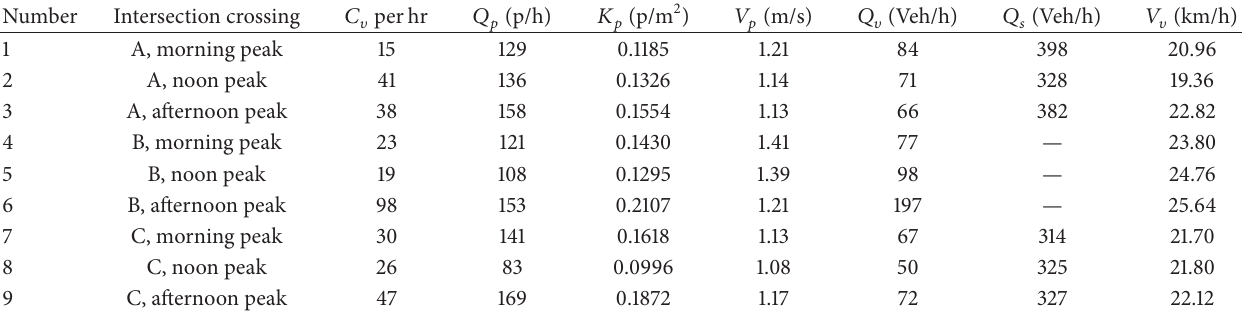
Figure 2: Illustration of conflict area. Table 1: Table of collected